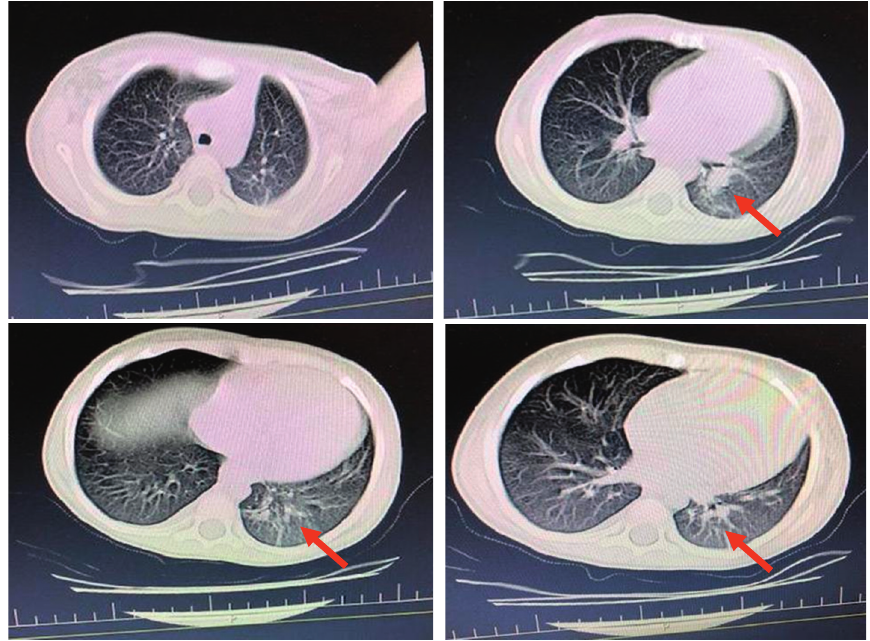
Figure 1: Spiral CT scan of chest without